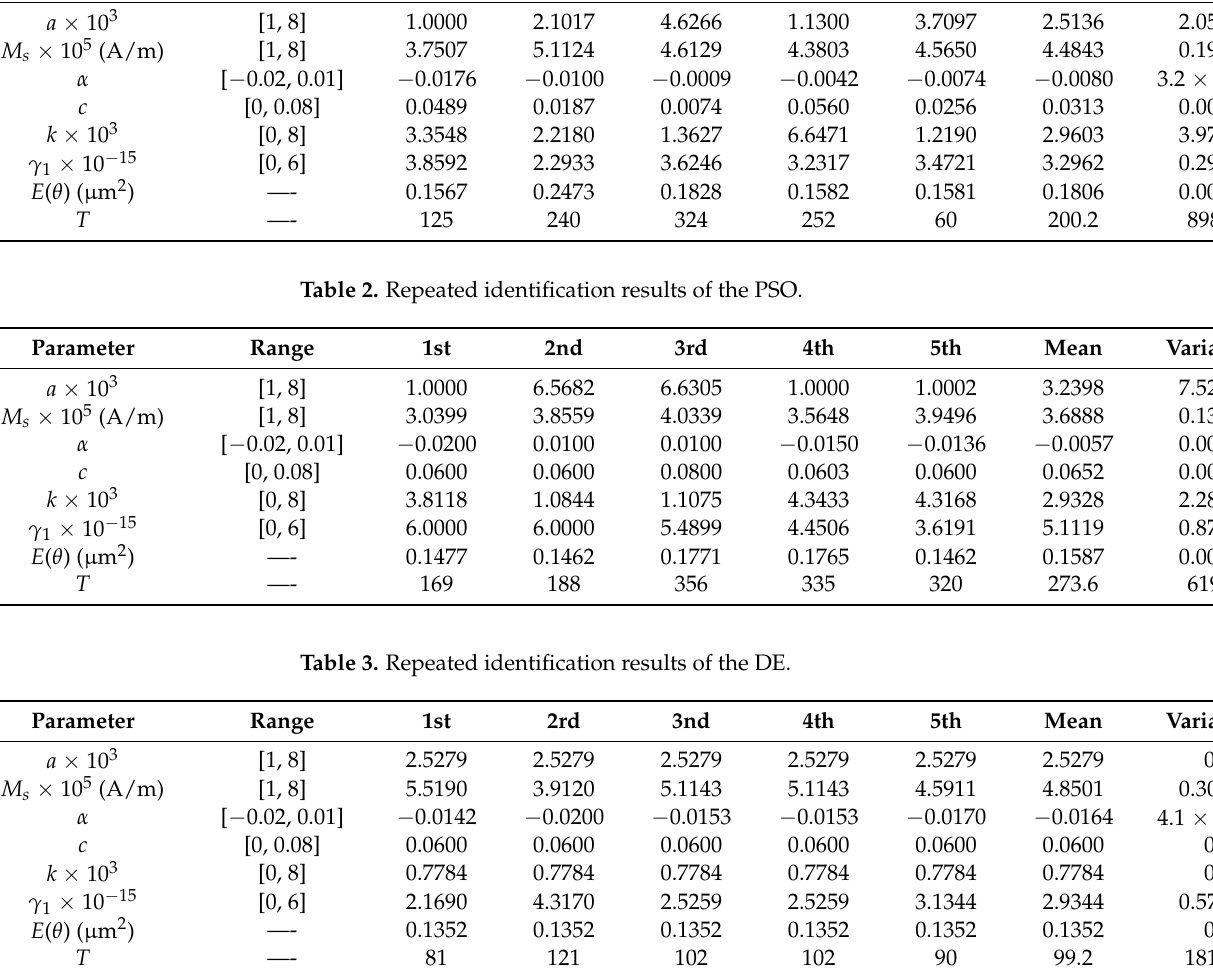
Figure 5. Identification evolution process: ( a ) GA; ( b ) PSO; ( c ) DE.